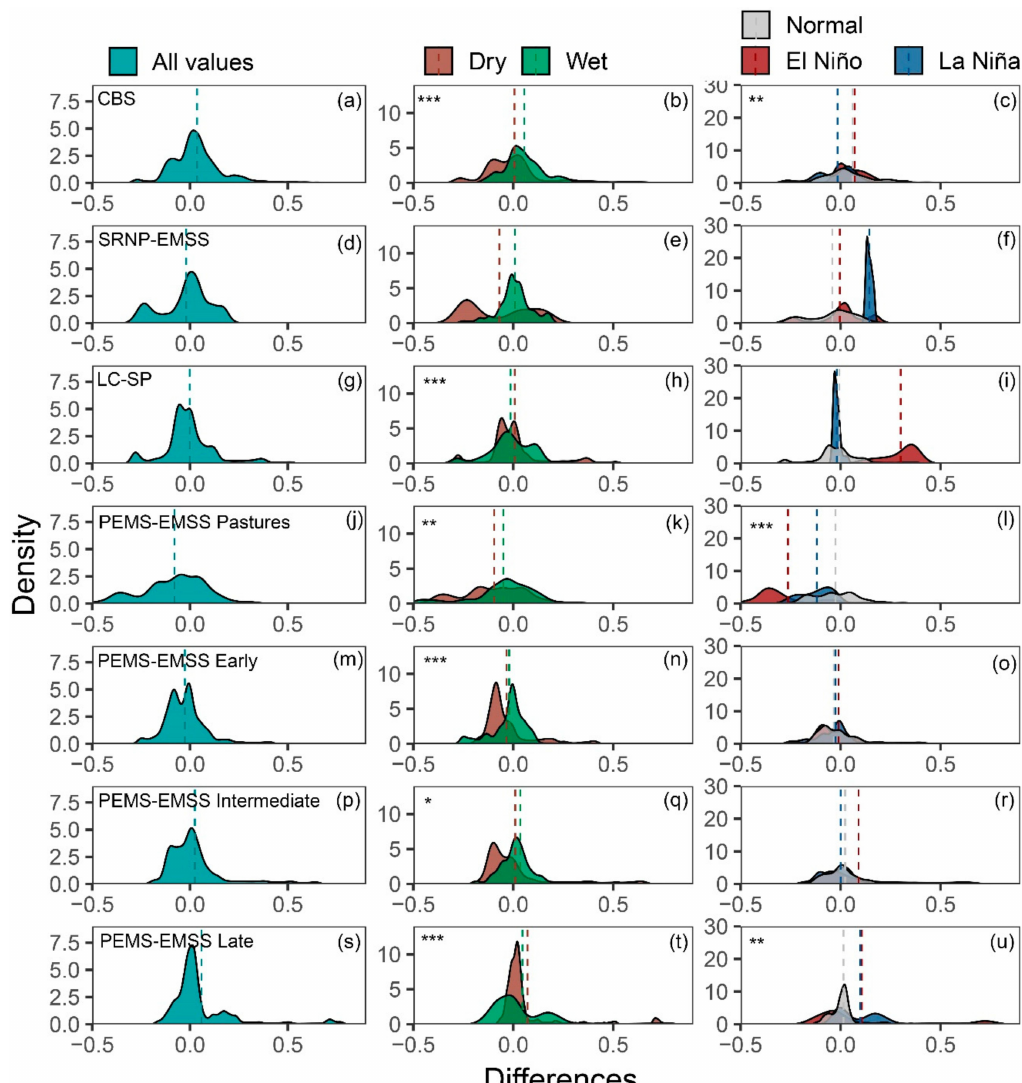
Figure 3. Density distribution of comparing standardized NDVI derived from near-surface and MODIS observations (Aqua and Terra) in di ff erent seasons (wet and dry season) and ENSO events at four tropical dry forests. Density curves were created using a Gaussian distribution with a bandwidth of 1. Vertical dotted lines represent the mean value of the overall errors per category. Asterisks describe the significant di ff erences of generalized least squares models between seasons or ENSO months (See Table 4 for detailed representation), as follows: * p < 0.05; ** p < 0.01; *** p <